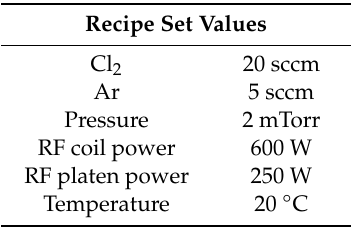
Table 1. The recipe of Au dry etch process parameters.